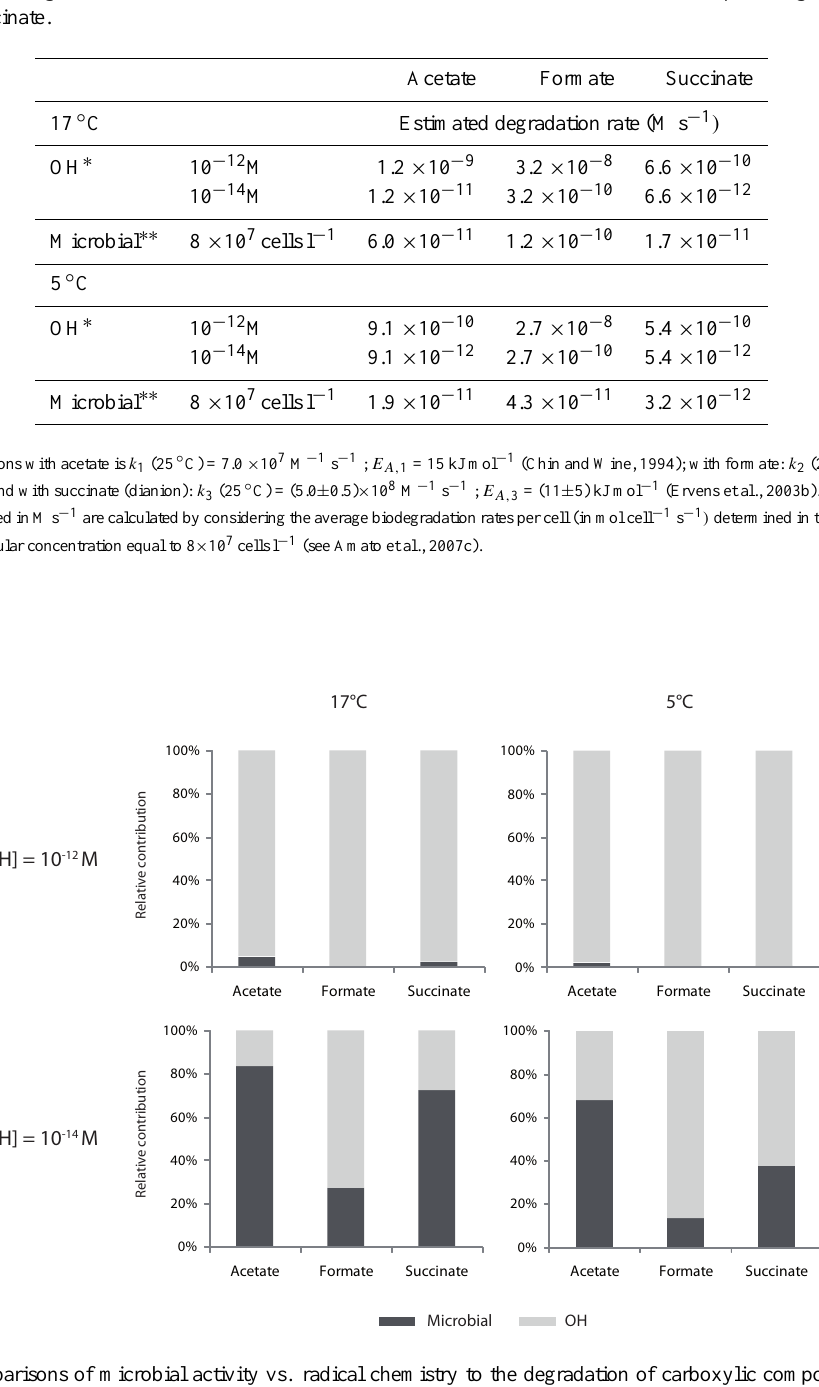
Fig. 3. Theoretical comparisons of microbial activity vs. radical chemistry to the degradation of carboxylic compounds in artificial cloud media. Relative contributions of each process were determined by comparison of biodegradation and photodegradation rates. Biodegradation rates per cell were measured experimentally (Table 2). Photodegradation rates were calculated using simulated standard OH concentrations in cloud water and reaction rates of OH towards the respective acids for two radical concentrations ([OH] = 10 − 12 M and [OH] = 10 − 14 M) (see Table